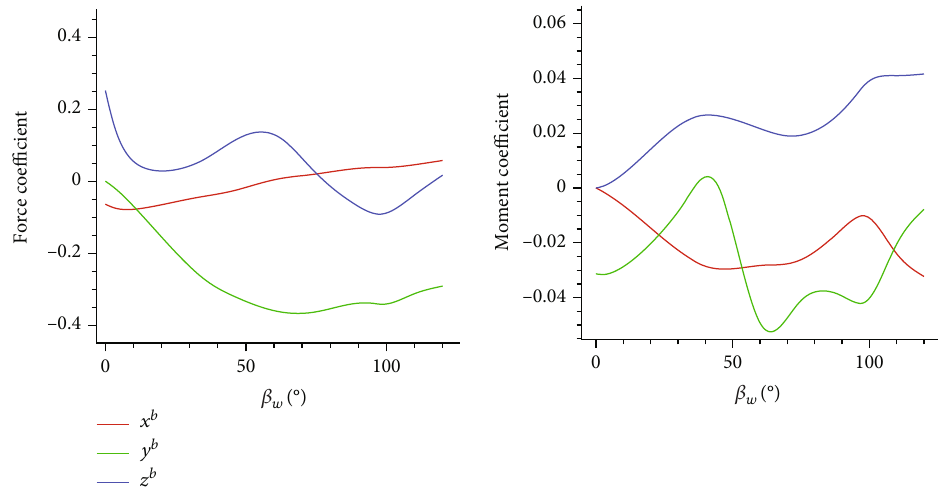
Figure 26: Aerodynamic coe ffi cients of the Quad-Plane at di ff erent β